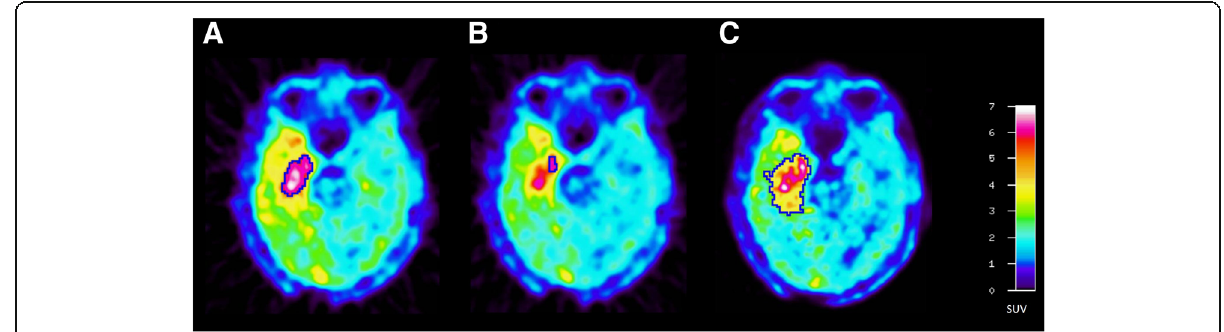
Fig. 3 ROI definition in a patient with a glioblastoma in the right temporal lobe. a The tumour volume as delineated by TBR > 1.8 based on data reconstruction of centre A . b The 90% isocontour of the 10 – 30-min image for TAC generation in centre A and c the tumour volume as delineated by a TBR > 1.6 in centre B which is also used TAC generation